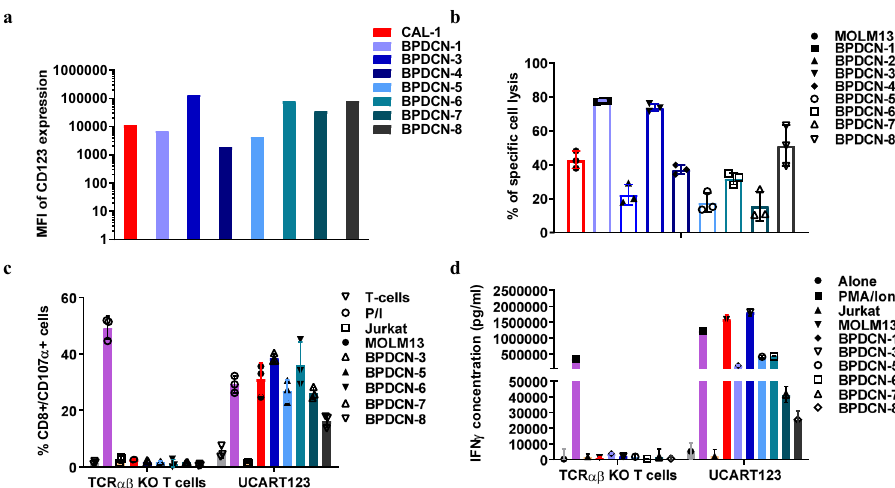
Fig. 2 Antitumor activity of UCART123 against primary BPDCN samples in vitro. a Expression of CD123 in CAL-1 cells and BPDCN patient samples was evaluated for 7 out of 8 samples by fl ow cytometry using 7G3 monoclonal anti-CD123-FITC antibody after gating on viable cells (DAPI − ). b Speci fi c cytotoxic activity against target cells (CD123 + MOLM13 cells and primary BPDCN samples) upon co-culture for 16 h with either UCART123 cells or TCR αβ KO T cells at E:T = 10:1. Each point represents the data obtained from triplicate experiments, and the mean ± SD value is presented. c CD107 α degranulation was measured by fl ow cytometry after gating on CD8 + cells. “ T cells ” correspond to the basal activity of unstimulated T cells, and PMA/Ion corresponds to the signal observed upon nonspeci fi c PMA/ionomycin stimulation. Degranulation activity upon co-culture of UCART123 or TCR αβ KO T cells with CD123 - Jurkat cells as well as CD123 + MOLM13 cells and fi ve different primary BPDCN samples is shown. Each point represents the data obtained from triplicate experiments, and the mean ± SD value is presented. d IFN γ release upon co-culture of UCART123 cells or TCR αβ KO T cells with CD123 − or CD123 + cells at E:T = 1:1 for 25 h. IFN γ levels were determined using the BioLegend LEGENDplex assay. PMA/ionomycin was used as a positive control. Each point represents the data obtained from triplicate experiments, and the mean ± SD value is presented. BPDCN-1, 2, 4 were not tested in all assays due to limited cell numbers. Source data are provided as a Source data fi le.